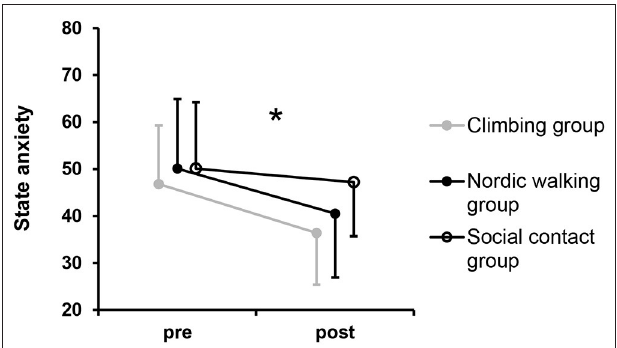
FIGURE 4 | State anxiety over time separated by groups. Circles represent mean values and error bars indicate standard deviations. *Indicates a significant time-by-group interaction.